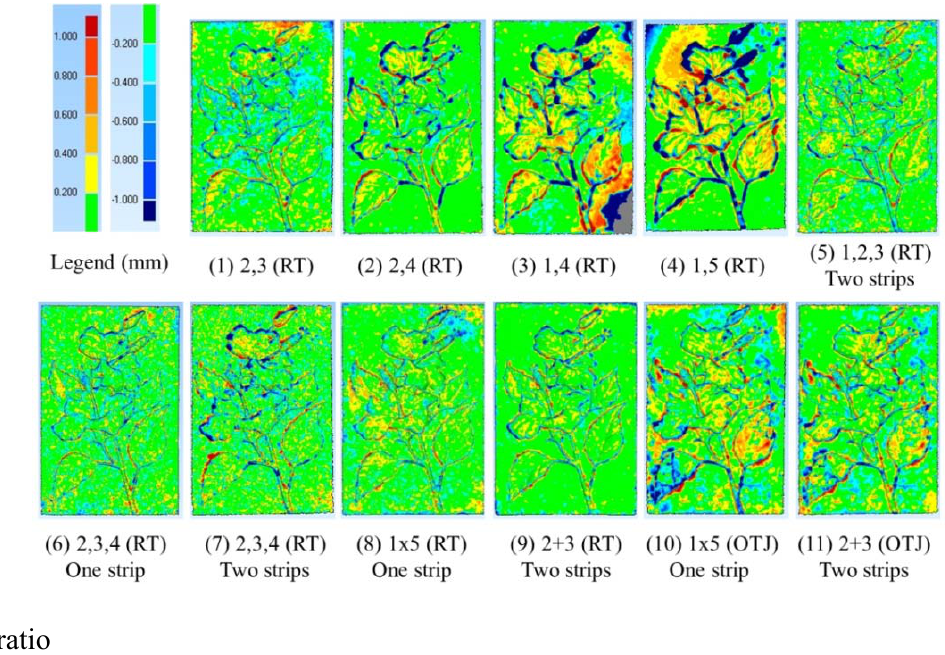
Figure 14. 3D error models for all modeling results (stone